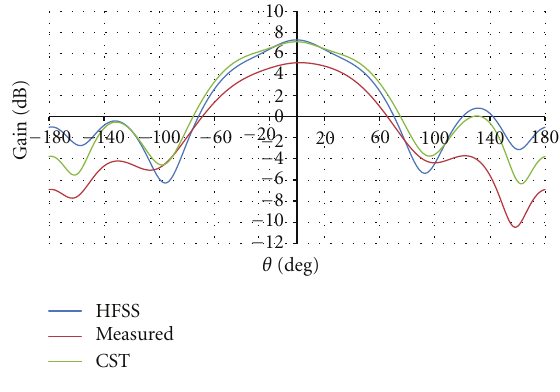
Figure 8: Gain plot at 6.1 GHz.